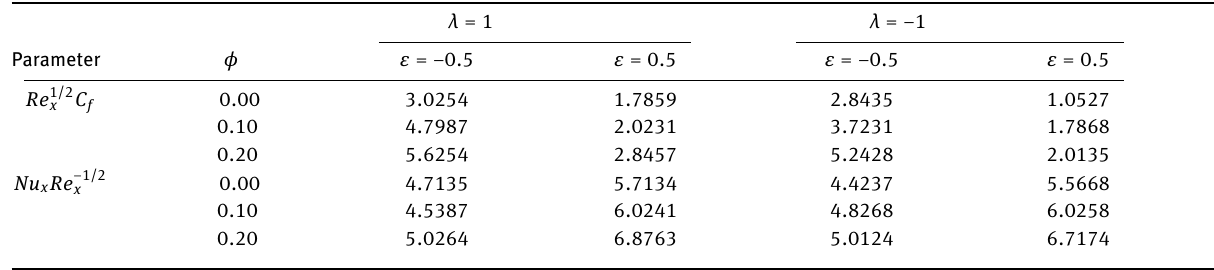
Table 5: The effect of the nanoparticle volume fraction on the skin friction coefficient and local Nusselt number for copper-sodium alginate nanofluid with A = 0.5, M = 1, U = 0.5. w λ = 1